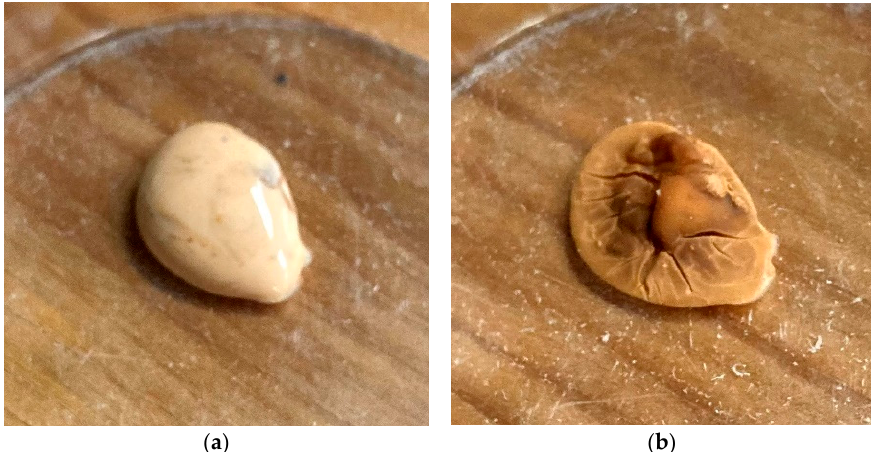
Figure 22. 500 mg samples of the consortium were dehydrated in a petri dish. ( a ) The wet culture, prior to drying; ( b ) the fully dehydrated culture.